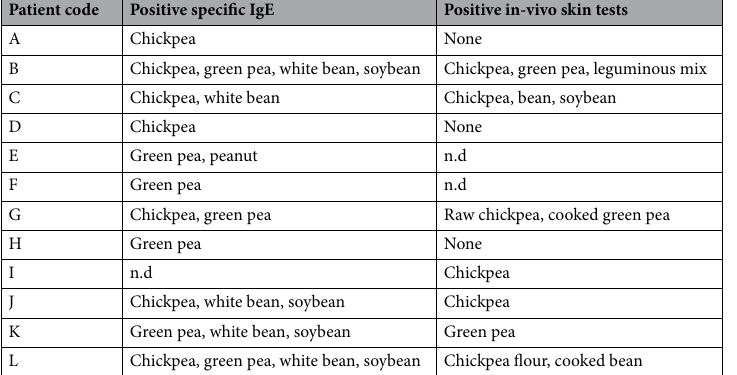
Table 1. Clinical characterization of the sera of the allergic patients. Patients are coded from A to L. n.d.: not